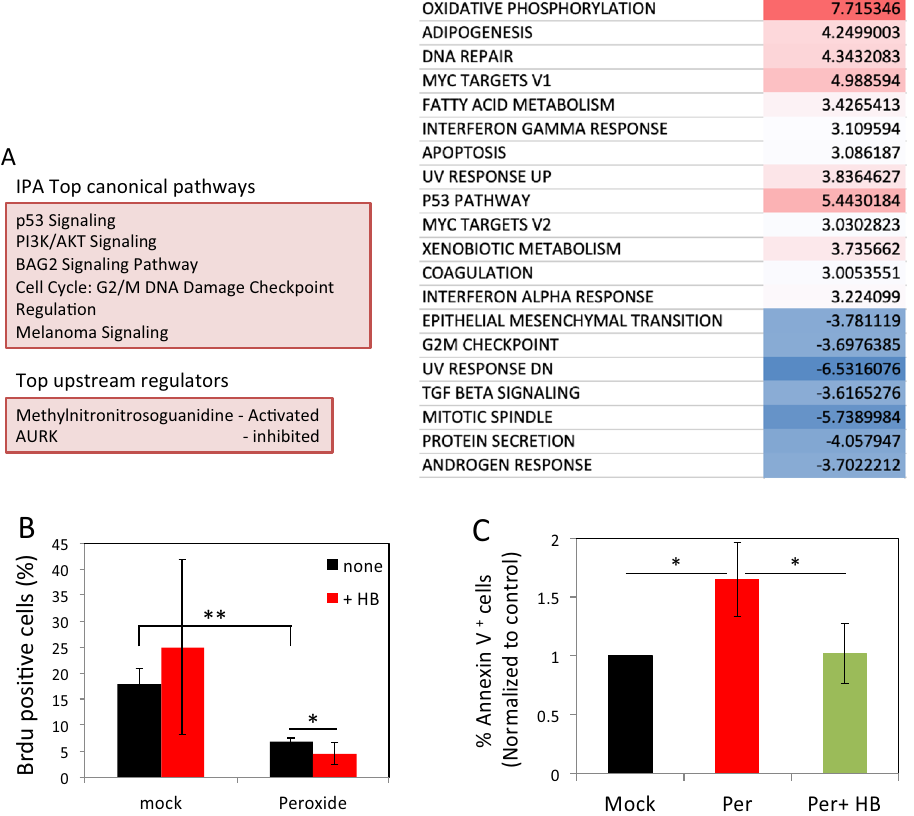
Figure 4. DNA damage alters gene expression profile and cellular response to HB-EGF triggering. ( A ) HF were treated as in Fig. 1A. After 30 and 90 min RNA was extracted and was subjected to RNAseq analysis. Differentially expressed genes altered with higher than twofold changes were selected. A list of IPA canonical pathways that are enriched in bleomycin treated cells stimulated with HB-EGF compared with those from HB-EGF stimulated mock cells (upper left panel). IPA upstream functional analysis was used to predict the top upstream regulators from differentially expressed genes (lower left panel). Gene set enrichment analysis (GSEA) pathways that are up-regulated (red) or down-regulated (blue) in response to HB-EGF treatment in bleomycin as compared with mock-treated cells (right panel). ( B ) Mock and peroxide (500 µM) treated cells were pulsed with BrdU for two hours immediately after treatment. After 24 h the cells were fixed and analyzed by flow cytometry. The percentage of BrdU positive cells is shown. Representative results of three independent experiments are shown. ( C ) Cells were treated as above and after 12 h were collected and stained with Annexin-V. The percentage of Annexin-V positive cells of three independent experiments was normalized to mock (set as 1). *p < 0.05; **p < 0.005; ns: